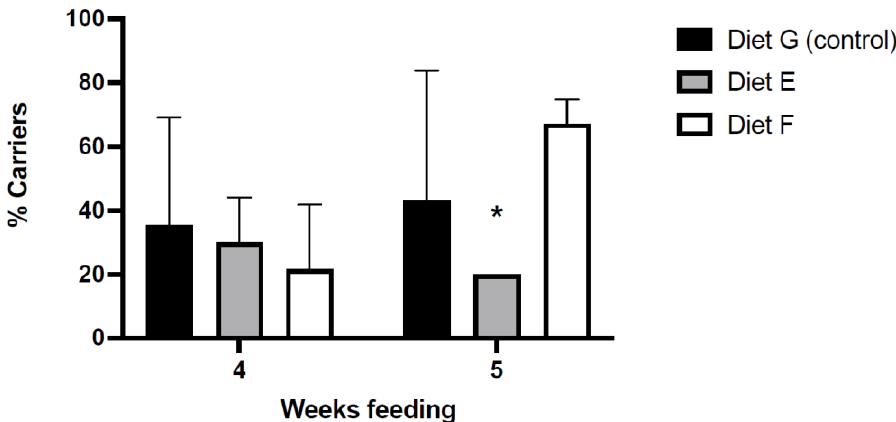
Figure 5. Average percentage of carrier animals among survivors fed functional diets (for 4 or 5 weeks) and challenged with Vibrio parahaemolyticus ( Vp AHPND strain). *: significant differences in mortality in group fed functional diet vs. group fed control diet (diet G).